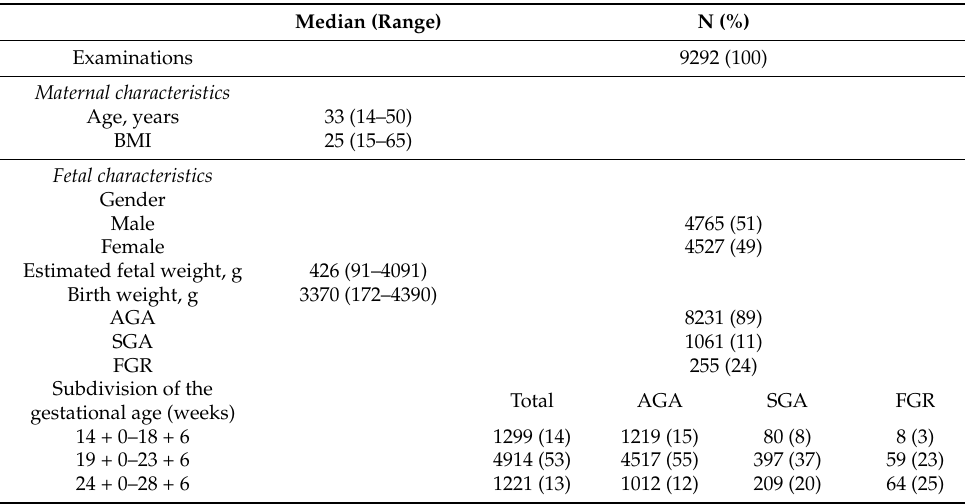
Table 1. Characteristics of the study